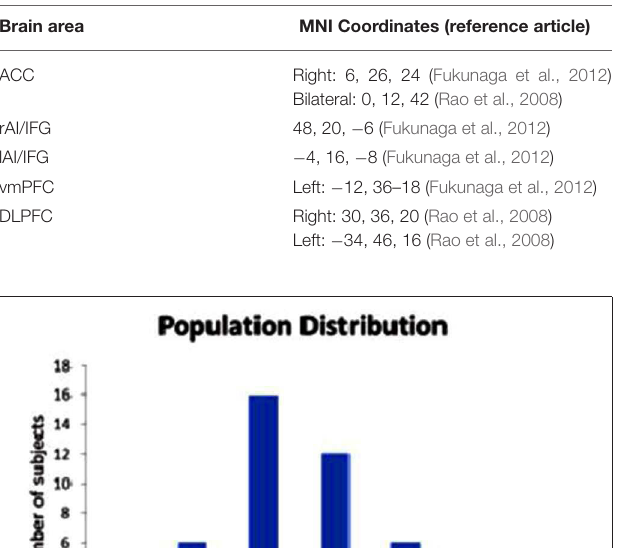
TABLE 1 | Candidate brain areas, Talairac coordinates and the reference articles linking them to BART score. Brain area